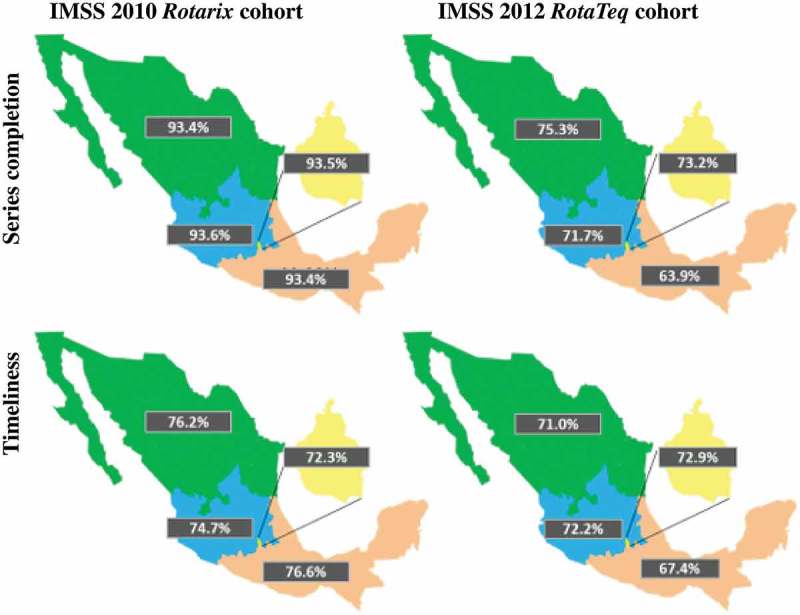
Rotarix and RotaTeq compliance (series completion, timeliness) by region.IMSS: Instituto Mexicano del Seguro Social; Rotarix: two-dose rotavirus vaccine; RotaTeq: three-dose rotavirus vaccine; Green: North region; Blue: Central region; Pink: South region; Yellow: Mexico City.